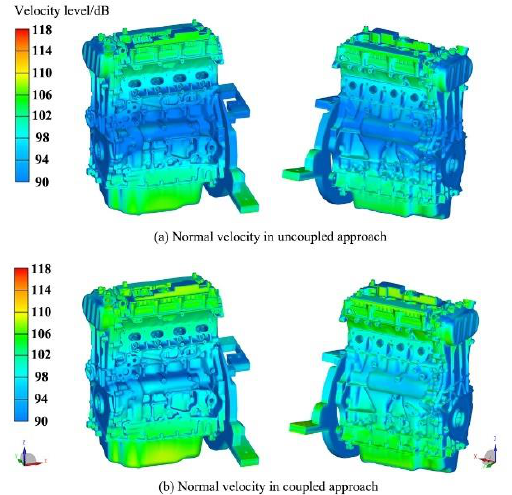
Figure 28. The colormaps of the vibration normal velocity level comparisons between the two approaches at the frequency of 166.7 Hz. Appl. Sci. 2020 , 10 , x FOR PEER REVIEW